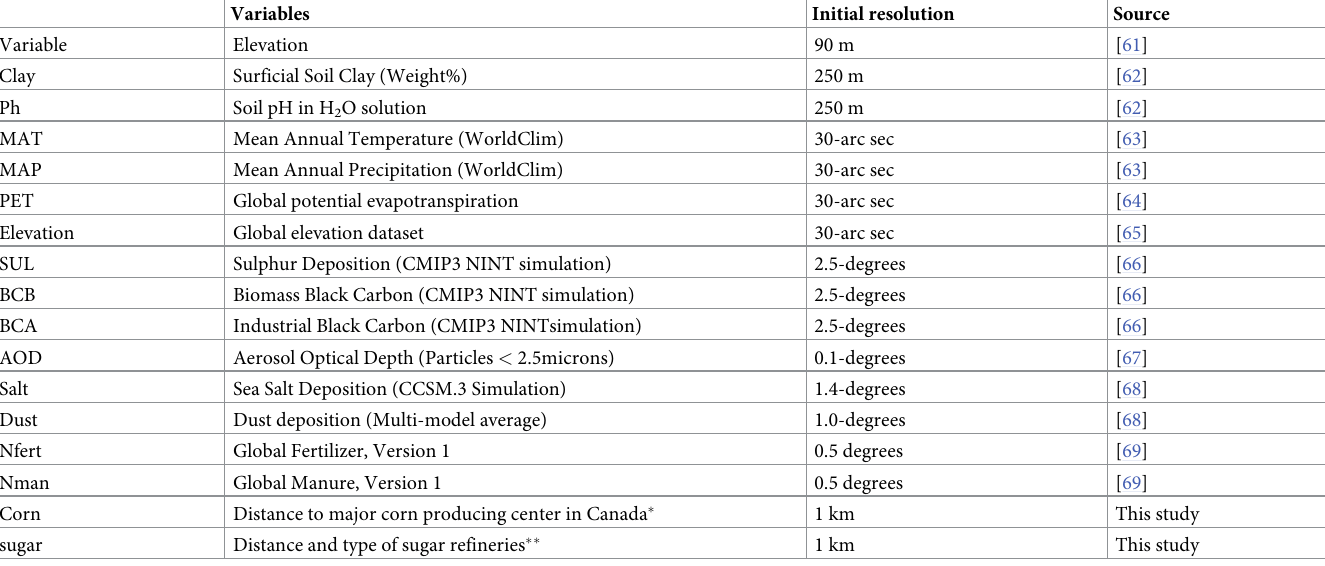
Table 1. Auxiliary variables. List of geological, climatic, environmental and topographic variables used for the